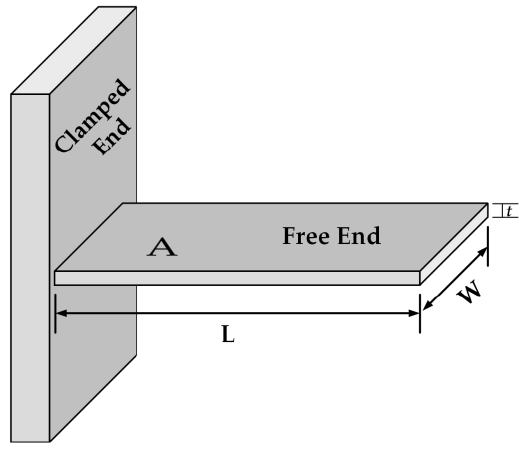
Figure 2. Geometry of prismatic cantilever beam.